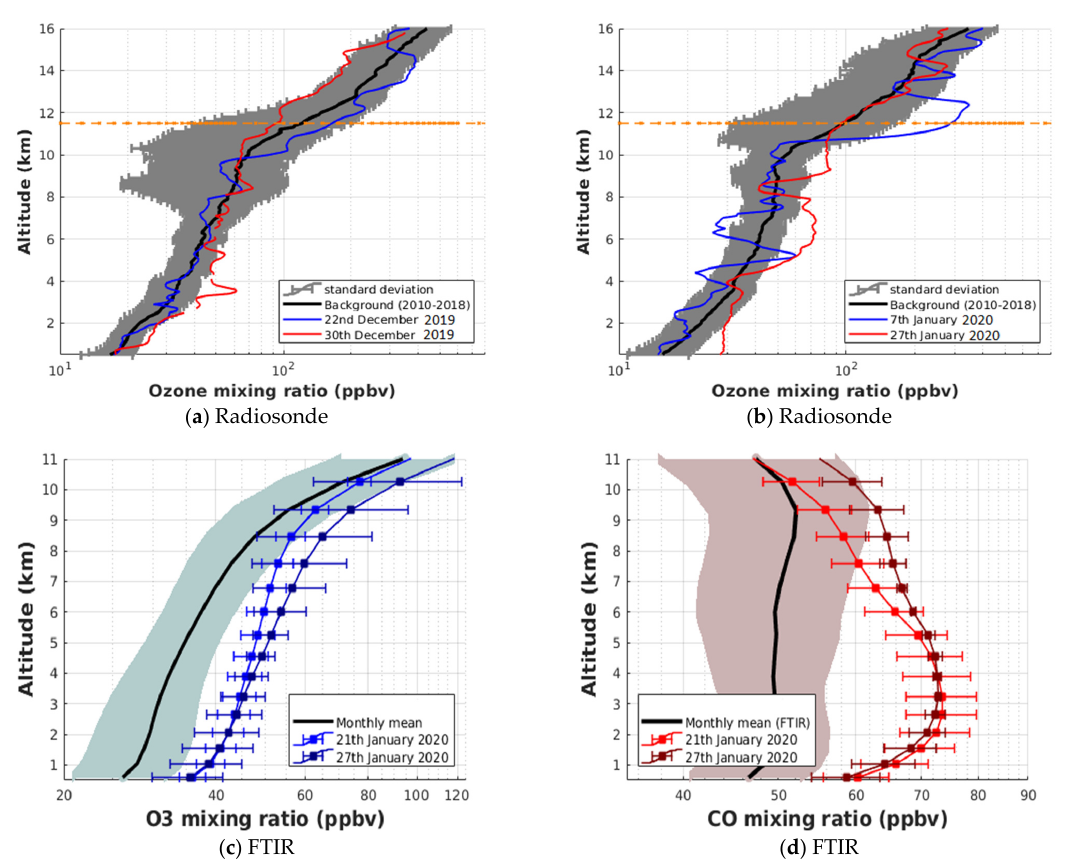
Figure 6. Available ( a – c ) ozone and ( d ) CO mixing ratio profiles obtained from ozone radiosondes and FTIR measurements at Lauder between December 2019 and January 2020. The monthly mean profile and the associated standard deviation calculated during the 2010–2018 period are in black line and shaded area, respectively. The tropopause height is indicated by the orange horizontal line.